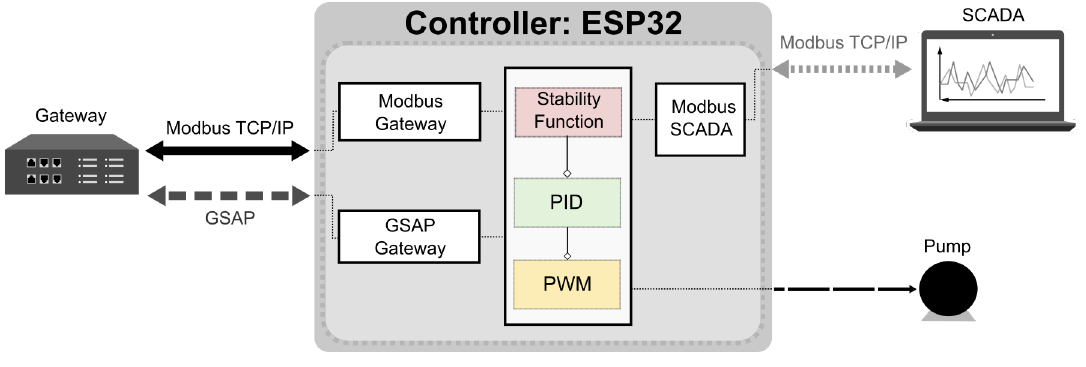
Figure 5. Controller